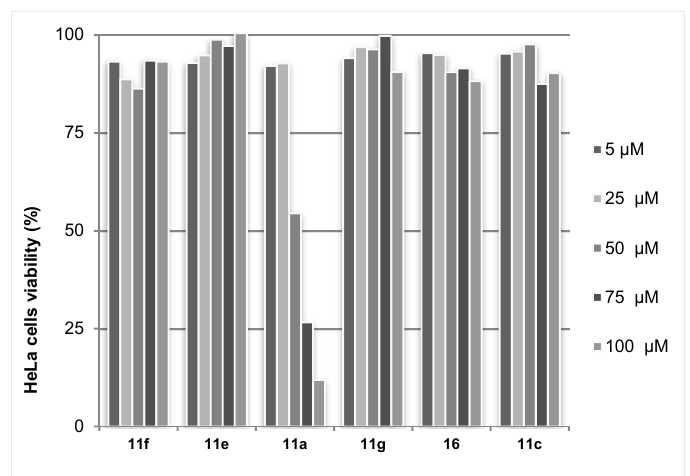
Figure 7. MTT test results with HeLa cell line for triazolylcinnolines 11,16.